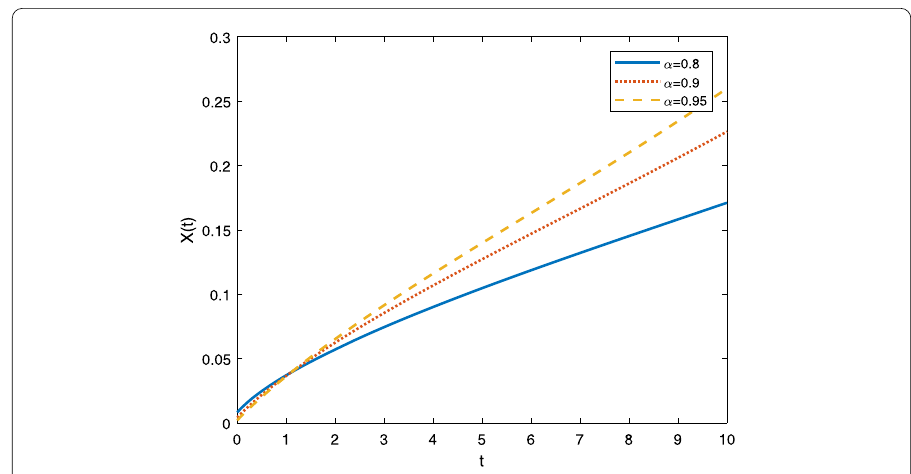
Figure 6 Amount of drug lidocaine in the bloodstream for various value of α